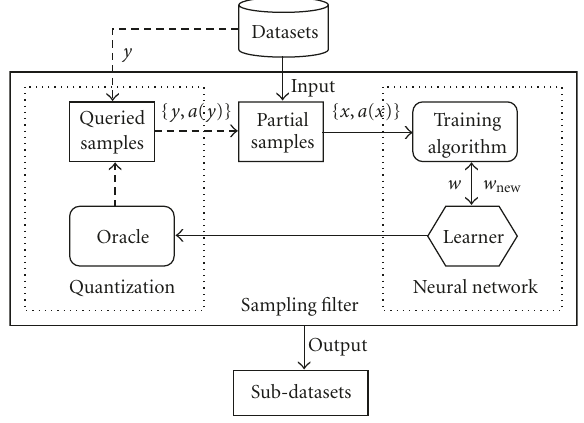
Figure 3: The framework of a QBS filter.